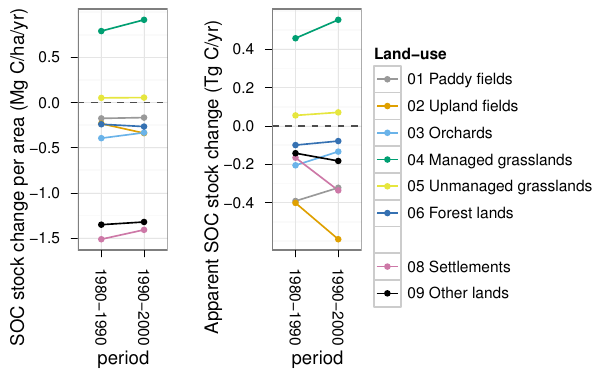
Figure 6. Rate of apparent soil organic carbon (SOC) stock changes in different land use and period during 1980–2008. Left panel shows annual rate of SOC stock change per area of each land-use type. Right panel shows annual rate of apparent SOC stock change of each land use with varying area. Note that for the apparent SOC stock change (right panel), increase in the area of a certain land- use type, occurred with no change in the rate of SOC stock change per area and will result in an increase in the quantity of this land- use type. The rate is expressed as a 10 year mean value. Positive and negative values on vertical axis indicate a gain and loss of SOC stock, which are equivalent to CO 2 removal from and emission to the atmosphere,